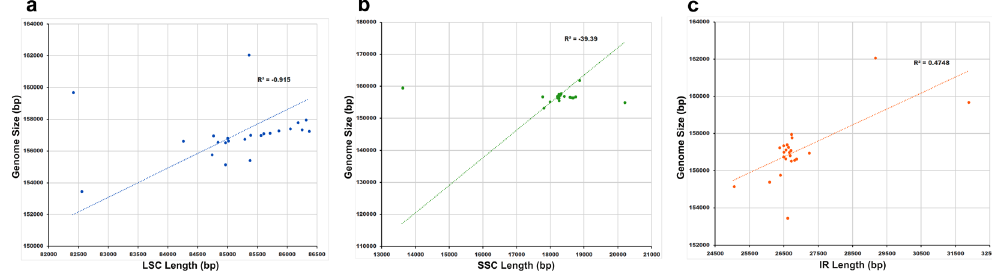
Figure 2. Relationships between Asparagales chloroplast genome sizes and large single-copy (LSC), small single-copy (SSC) and inverted repeat (IR) region